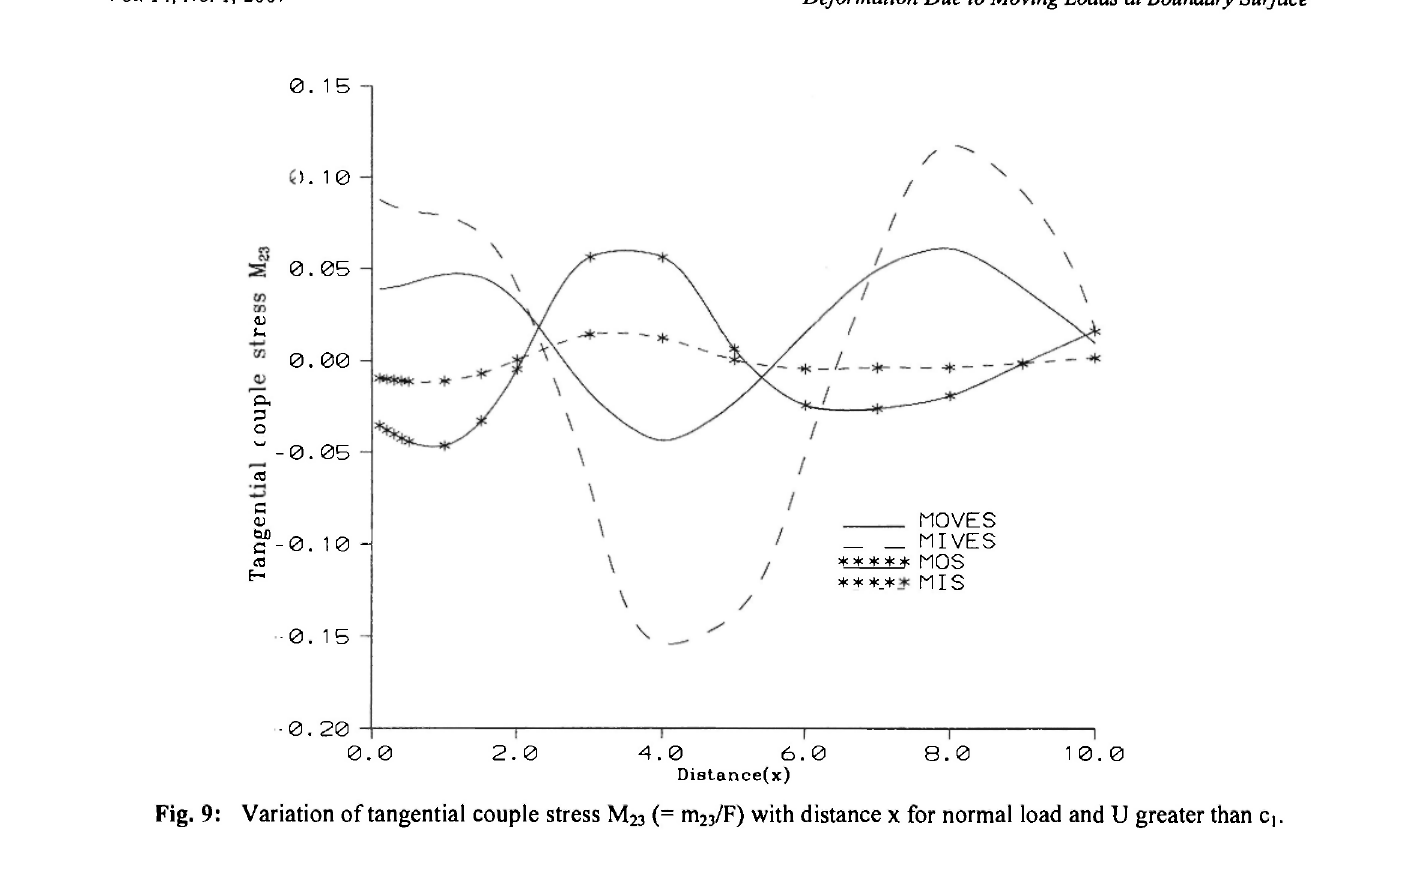
Fig. 9: Variation of tangential couple stress M 23 (= m 23 /F) with distance χ for normal load and U greater than c : .